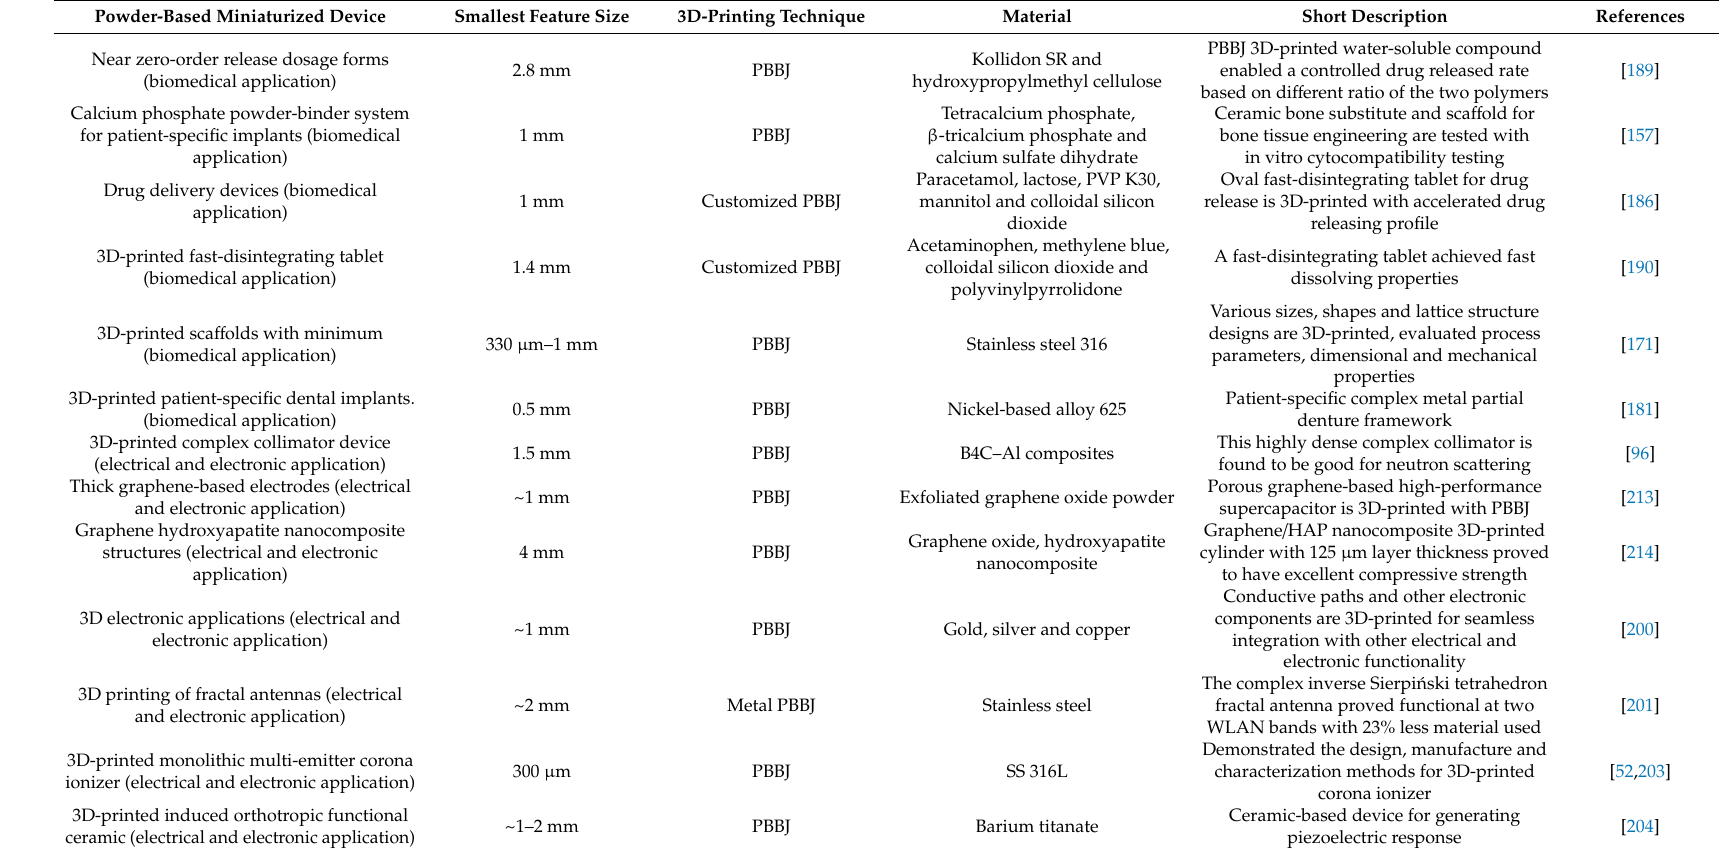
Table 2. Summary of all powder-based devices with miniaturized